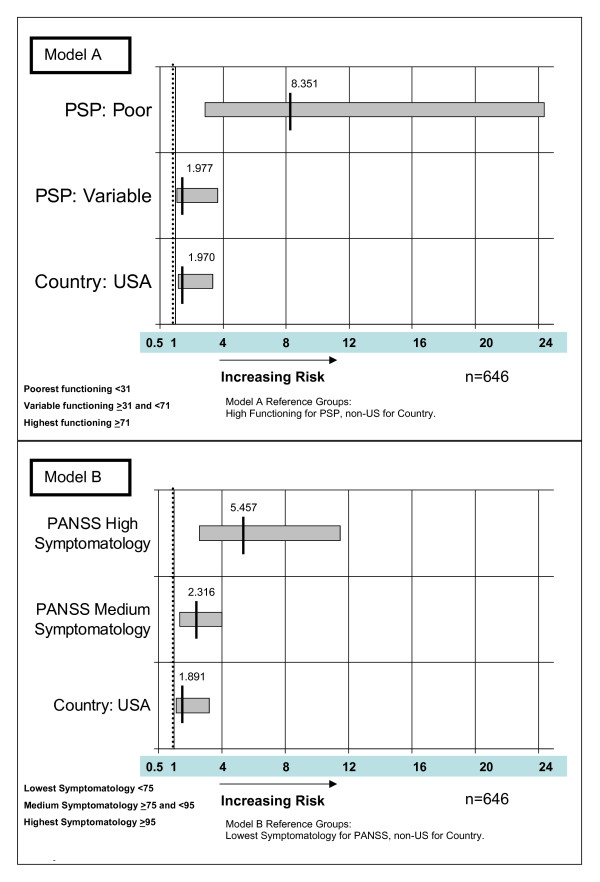
Hazard ratios for significant variables in the two Cox proportional hazard regression models predicting hazard (risk) of hospitalization using Personal and Social Performance (PSP) scale (model A) and Positive And Negative Syndrome Scale (PANSS) (model B).